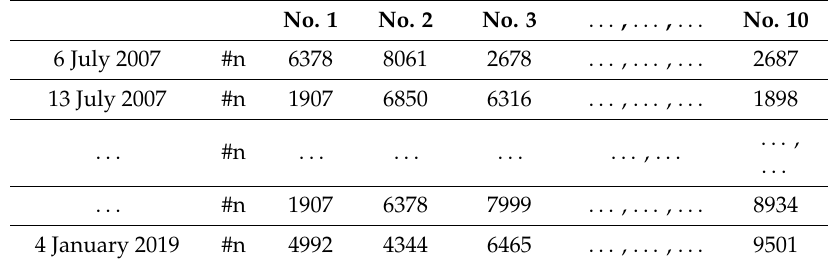
Table 1. Weekly data on top up-pricing stocks. The white cells show the data content, where “#n” represents the beginning of each basket of top up-pricing stocks for each week, and each 4-digit integer shows a stock ID. This table shows a sequence of top-10 up-pricing stocks. A row includes five stock IDs for top-5 up-pricing